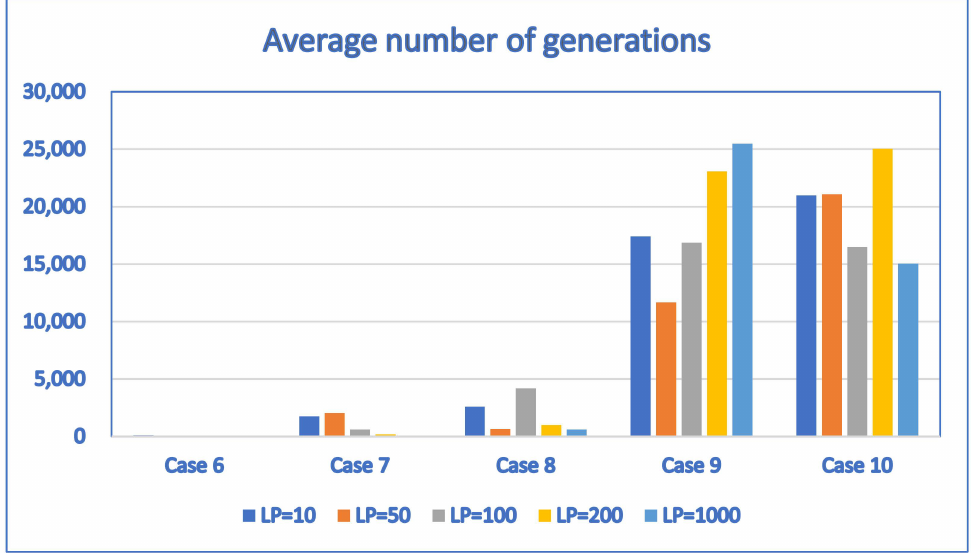
Figure 4. The average number of generations for Case 6, Case 7, Case 8, Case 9 and Case